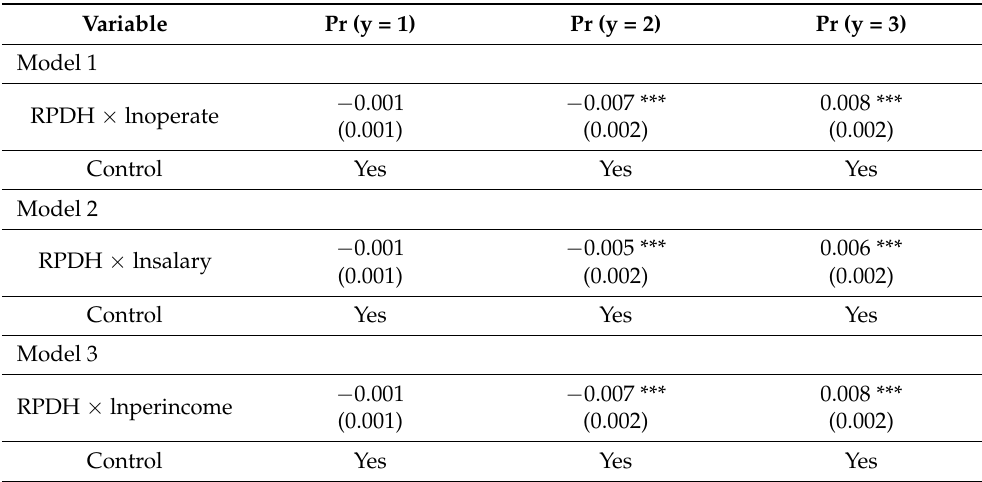
Table 12. Marginal effects of the main variables under different thresholds. Variable Model